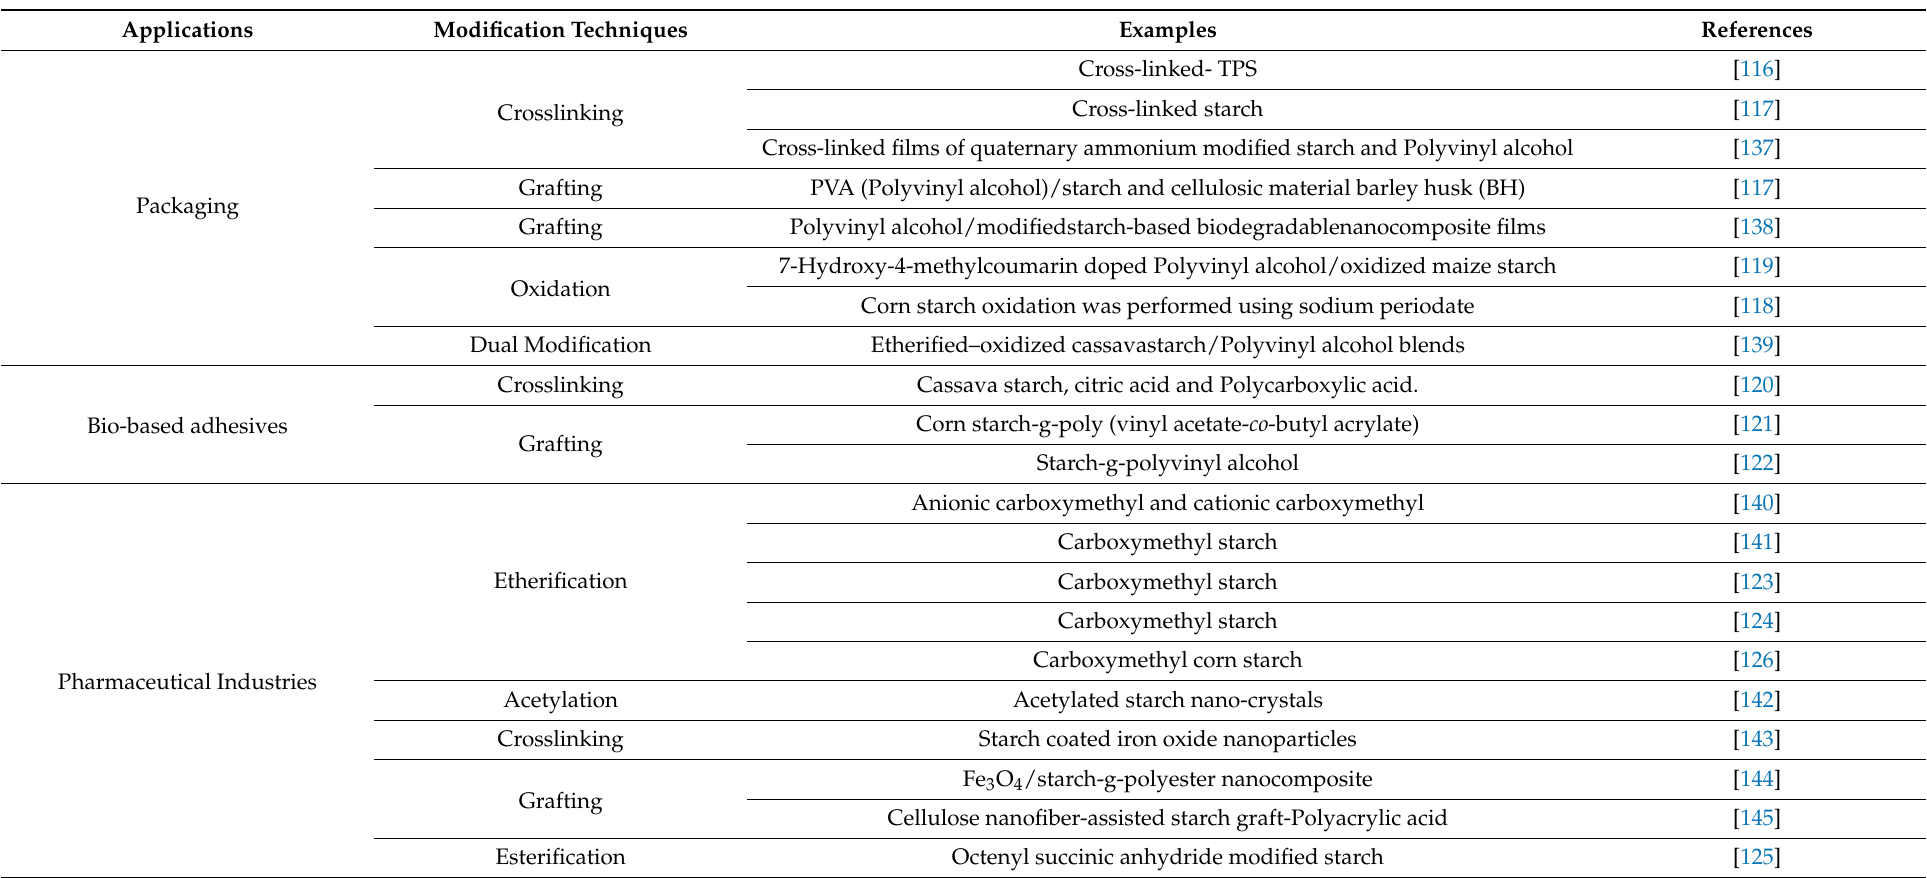
Table 5. Key applications of modified